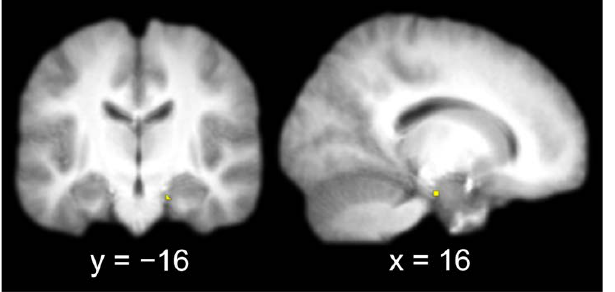
Figure 3. Entorhinal cortex seed (identified by contrasting item memory hits and misses and extract- ing a 3 mm radius sphere around the most significant coordinate of the activation; left, coronal slice; right, sagittal slice).